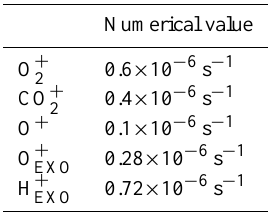
Table 1. Ion production frequencies. The ions are produced by pho- toionisation. Exospheric ions are additionally produced by charge exchange with solar wind